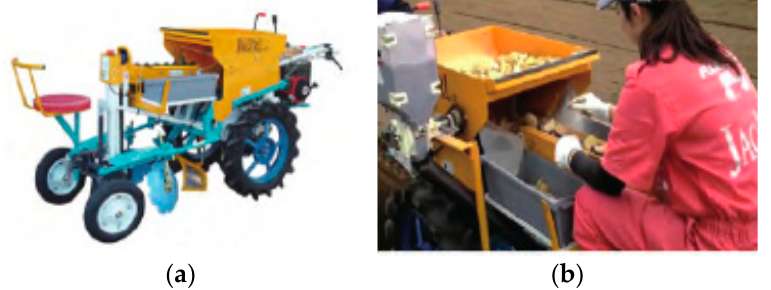
Figure 19. JAGIRL man-aided potato planter ( a ) The structure of planter. Reprinted with permission from ref. [13] Copyright 2019 JAGIRL Industries ( b ) Manual assisted operation. Reprinted with permission from ref. [13] Copyright 2019 JAGIRL Industries.